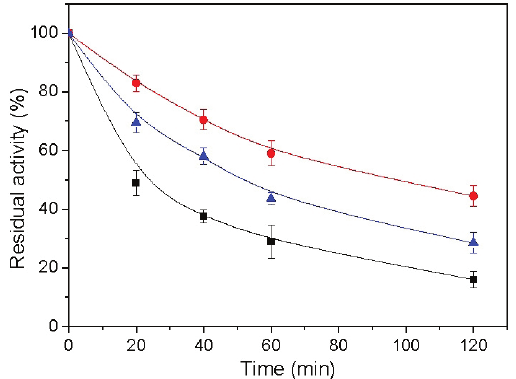
Fig. 5 – Thermostability of immobilized CCA in the presence of inhibitors. The immobilized CCA was incubated at 50 °C in sodium phosphate buffer (20 mmol L –1 ; pH 8.0) with 50 mmol L –1 sodium acetate or sodium bicarbonate. The enzyme activity was measured after the inhibitors were thoroughly washed out with phosphate buffer. No inhibitor (triangle), sodium bicar- bonate (circle), and sodium acetate (square).